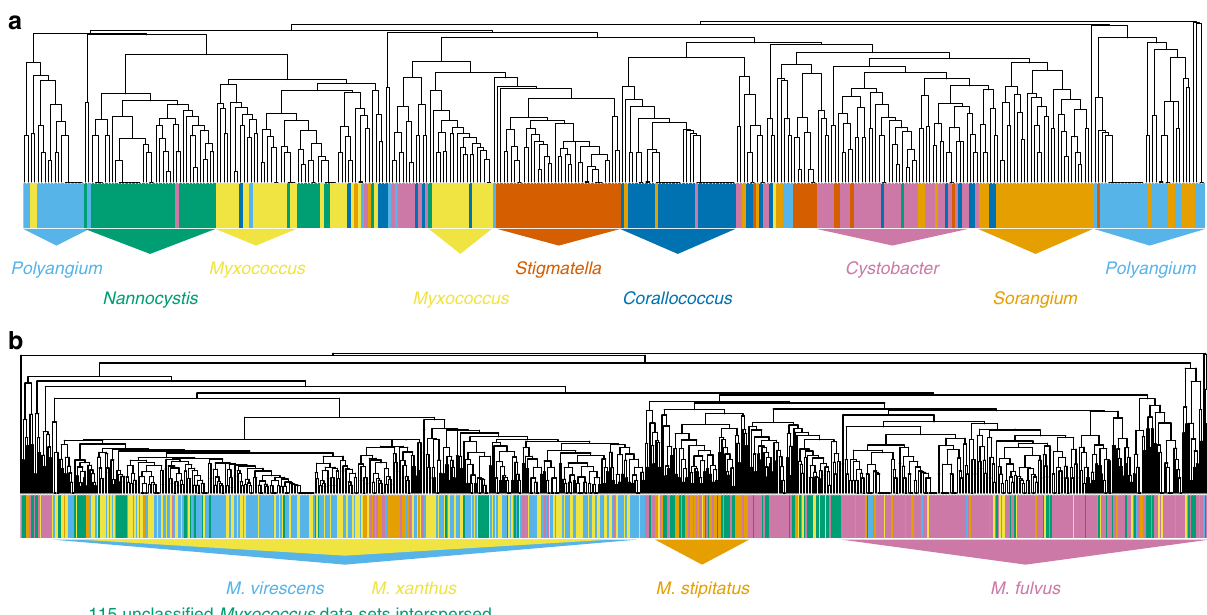
Fig. 3 Metabolite pro fi les clustering by taxonomy. a Clustering of 350 data sets based on the distribution of identi fi ed known myxobacterial compounds. Each of the 7 most abundant myxobacterial genera is represented by 50 randomly selected data sets with a distinguishable color coding. Colored triangles indicate regions which are enriched with data sets of a single genus. A total of 94 compound families was found amongst these data sets. b Clustering of all available Myxococcus data sets (790) covering a varying number of representatives of M. virescens (189, blue), M. xanthus (154, yellow), M. stipitatus (76, orange), M. fulvus (256, magenta), and unclassi fi ed Myxococcus species (115, green). See Supplementary Figures 6 and 7 for additional